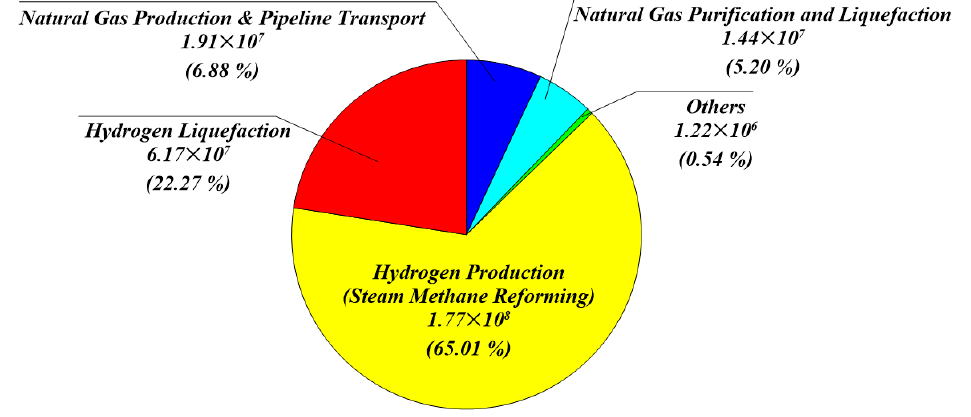
Figure 6. GWP fractions from hydrogen using electricity in the ROK (Case 3-4) in the Well-to-Tank phase.